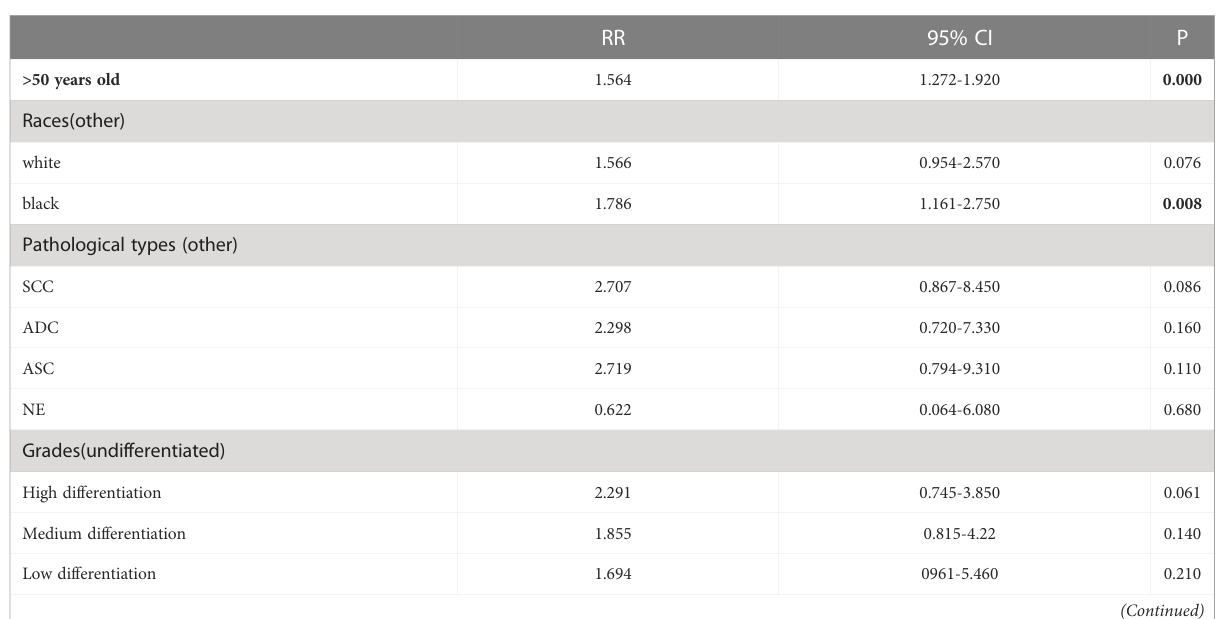
TABLE 3 The multiple competes risk